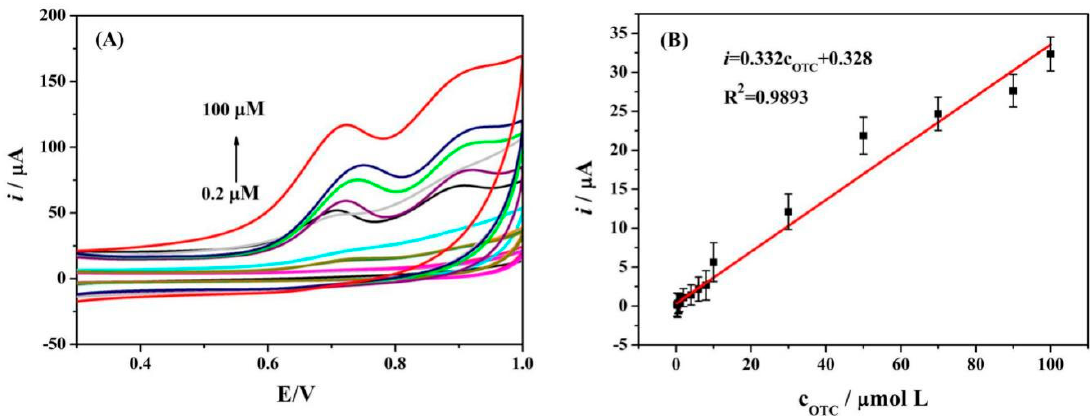
Figure 8. ( A ) Cyclic voltammetry obtained on Ta 2 O 5 -ErGO / GCE in 0.1 M PBS (pH 6.5) containing different concentrations of oxytetracycline (OTC) (0.2, 0.4, 0.6, 0.8,1, 2, 4, 6, 8, 10, 30, 50, 70, 90, and 100 µ M). ( B ) The linear relationship between the anodic peak currents ( i pa ) of OTC and OTC concentration (c OTC ) in the range of 0.2–100 µ M. Table 1. Different modified electrodes for the detection of oxytetracycline. Electrochemical Electrode Techniques